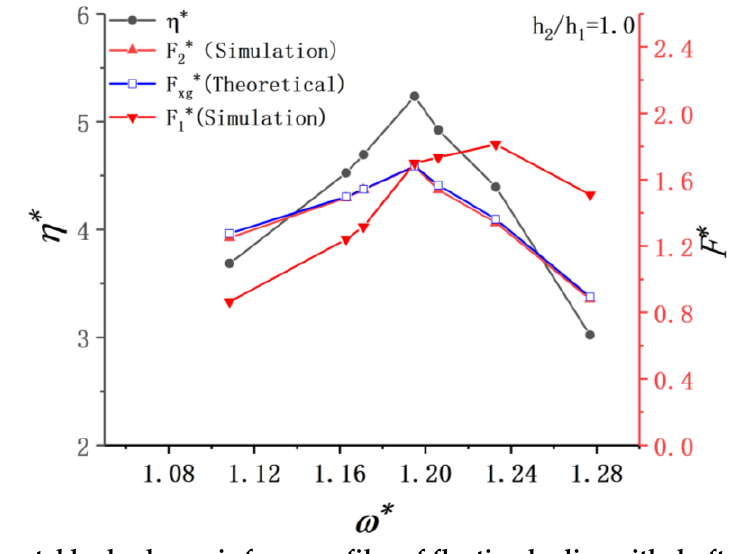
( b ) Horizontal hydrodynamic force profiles of floating bodies with draft ratio of 1.0 .